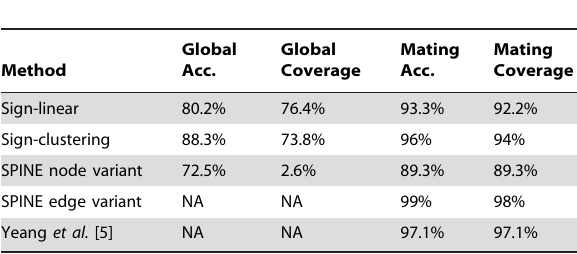
Table 1. Performance comparison in predicting knockout